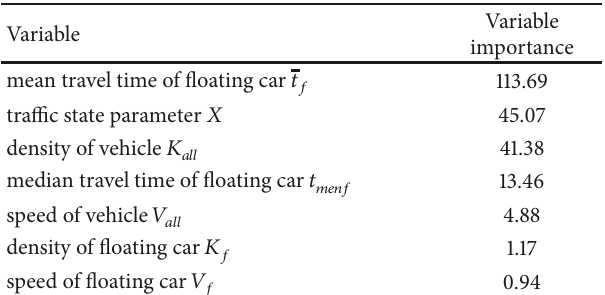
Figure 7 is travel time obtained by different